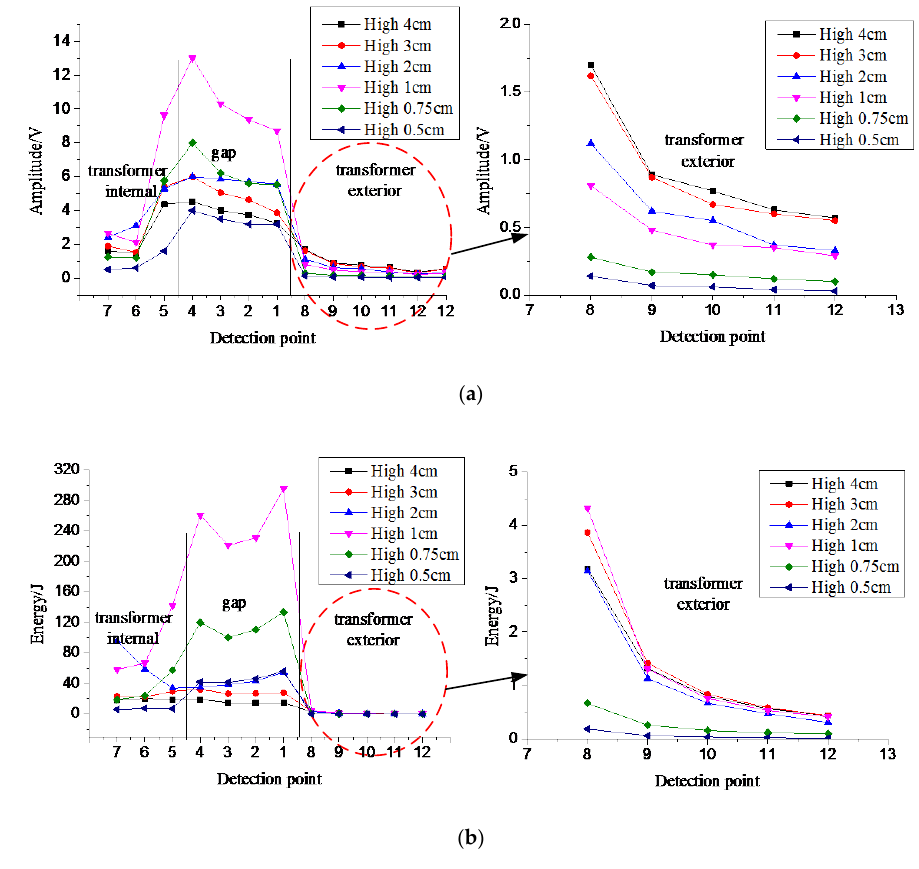
Figure 12. Distributions of PD electromagnetic signals in different height gaps: ( a ) Amplitude Distributions of PD electromagnetic signals in different height gaps: distribution; ( b ) Cumulative energy distribution. ( a ) Amplitude distribution; ( b ) Cumulative energy